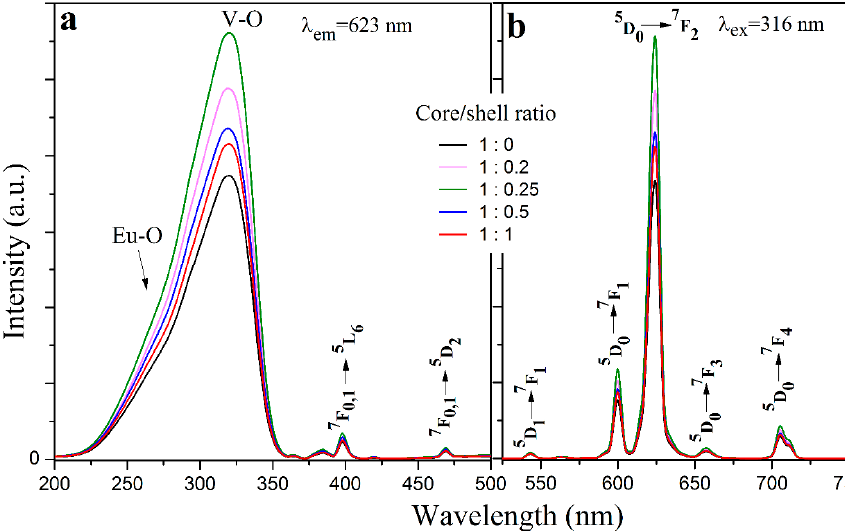
Figure 7. The excitation ( a ) and emission ( b ) spectra of the YVO 4 :Eu 3+ @YVO 4 core-shell nanoparticles with different core/shell ratios.